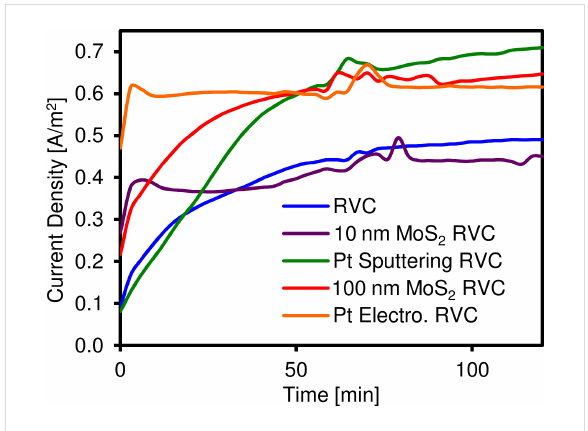
Figure 7: Current generated per area of the uncoated and coated electrodes over time. The currents have been normalized as a func- tion of the RVC area of 21 cm 2 with a total accessible surface area of 249.6 cm 2